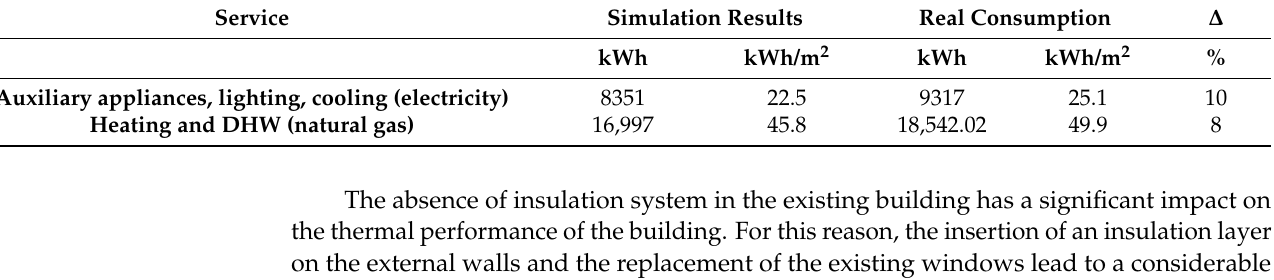
- Table 7. Use of renewable energy sources to achieve the NZEB target for the three proposed scenarios. Type Property